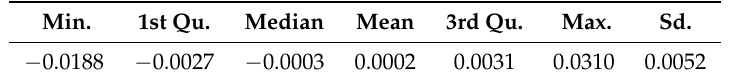
Table 2. Summary statistics of return data on the foreign exchange (FX) rate. Min.